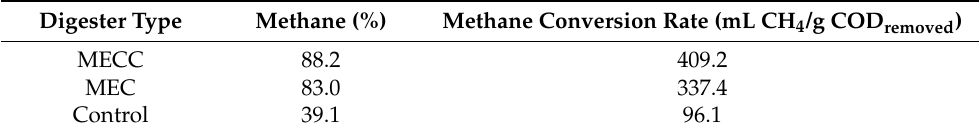
Table 1. Methane composition and methane conversion